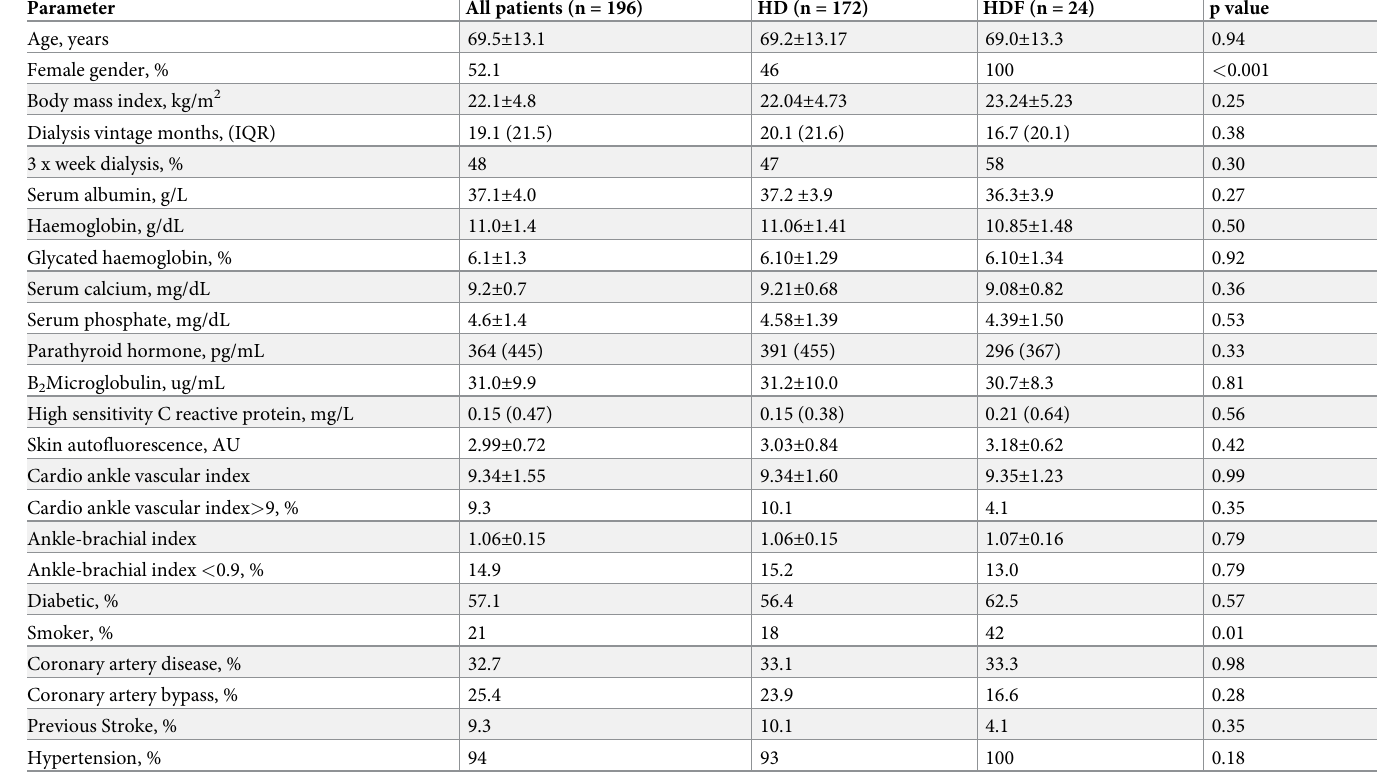
Table 1. Patient demographics, relevant medical conditions laboratory investigations, and assessment or peripheral vascular disease and comparison of treatment with high-flux haemodialysis (HD) and